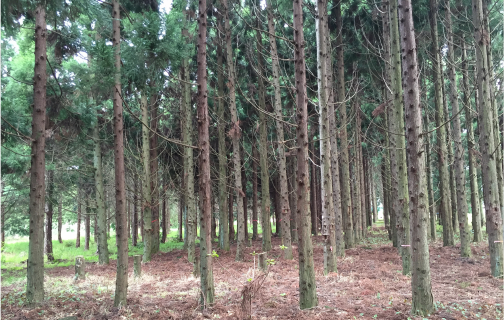
Figure 12. Forest in the Forest Tree Breeding Center